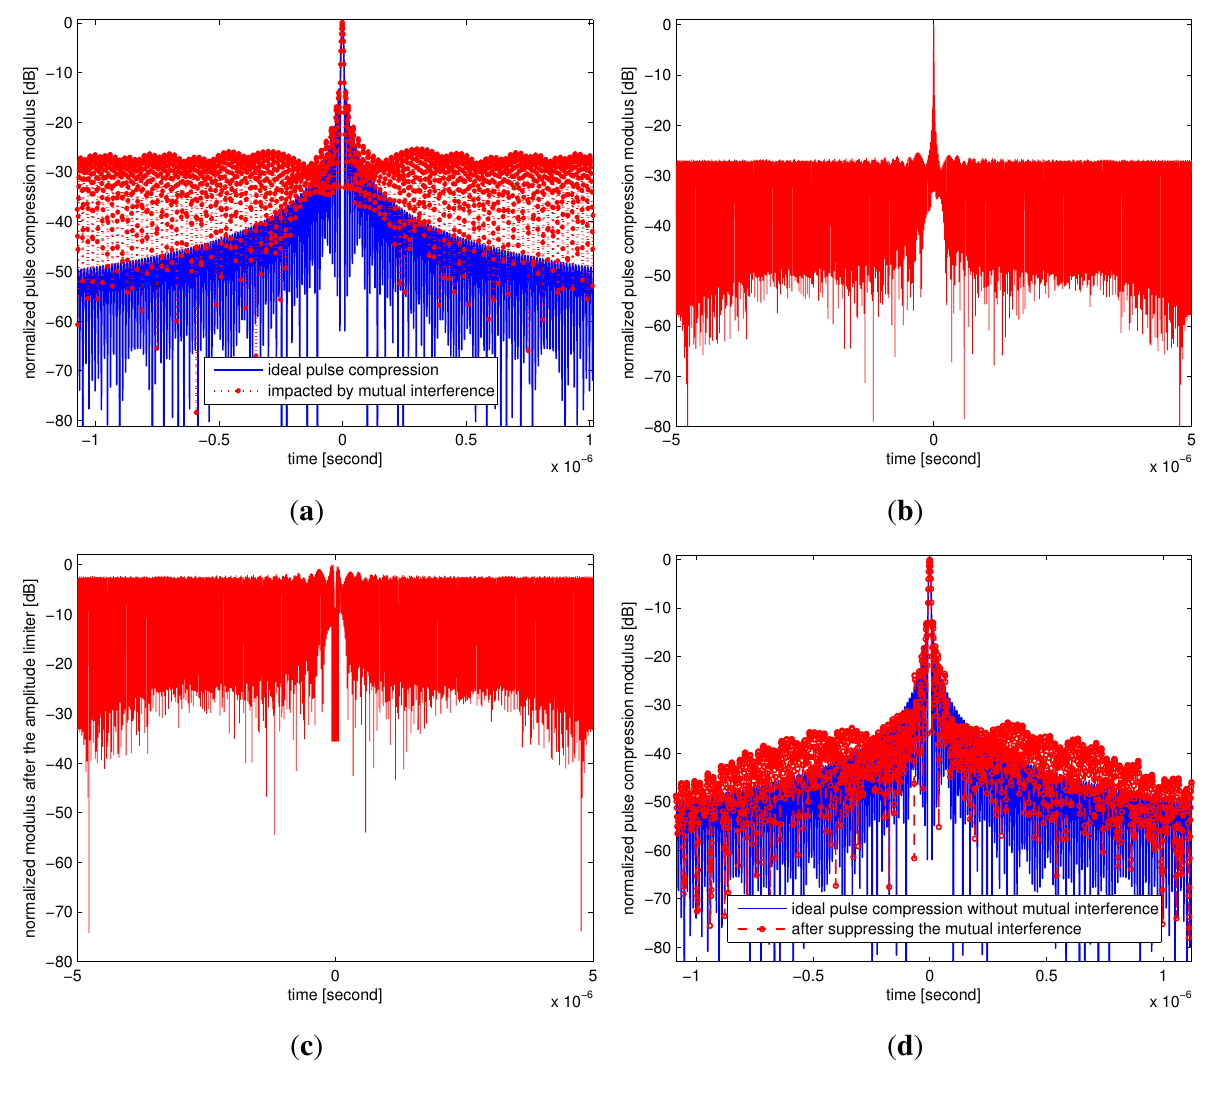
Figure 4. Comparative pulse compression results for the two radars with down-chirp and up-chirp waveforms. ( a ) Ideal result and mutual interference; ( b ) pulse compression using the second waveform as the reference function; ( c ) after being processed by the iterative suppression algorithm; ( d ) final matched filtering results for the first